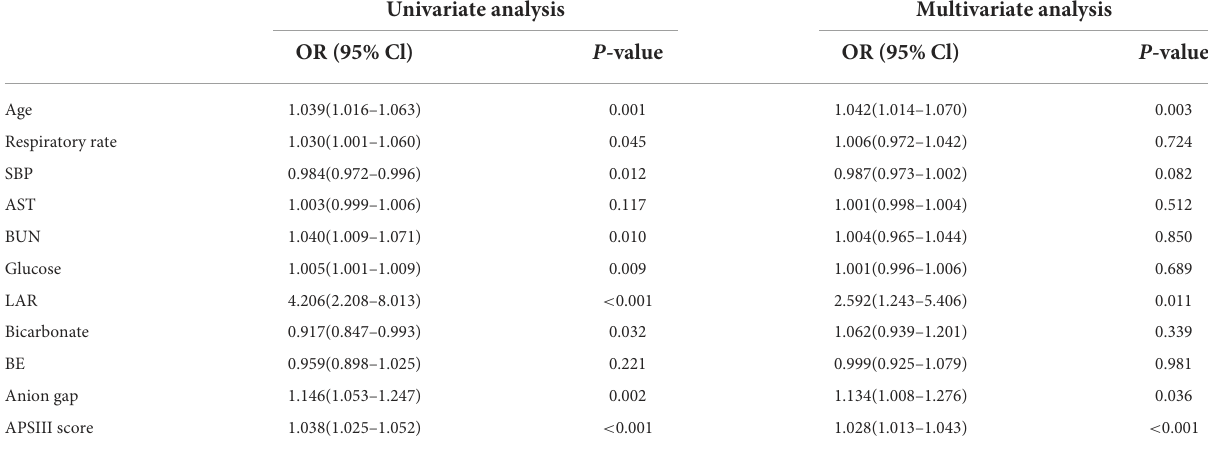
TABLE 2 Univariate and multivariate logistic regression analysis of factors associated with